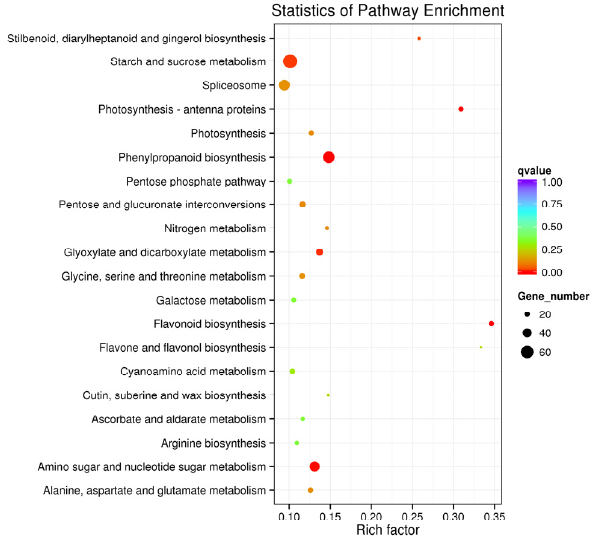
Figure 5. Functional gene ontology classification of DEGs. The y -axis indicates the number of DEGs in a category.